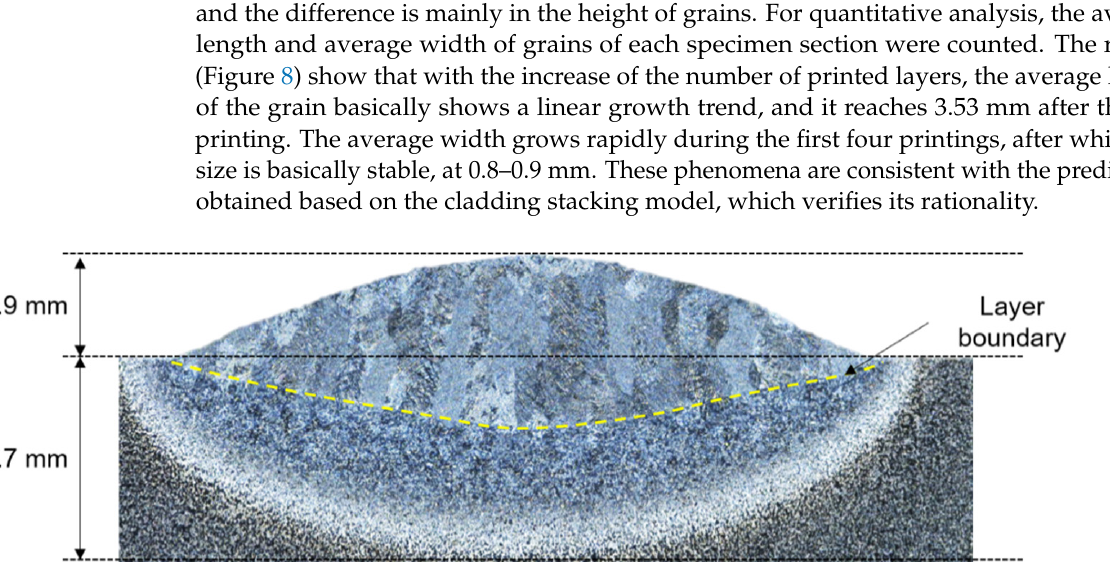
Figure 8. The average length and average width of grains. 3. A Process–structure–property Multi ‐ Scale Simulation Framework The cladding stacking model provides a basis for predicting the macro ‐ scale mechan ‐ ical properties of the final fabricated component by using meso ‐ scale scale numerical sim ‐ ulation results. For example, under the process parameters of the Section 2.2, the meso ‐ scale numerical simulation only needs to simulate the cladding processes of four layers. Then, the macroscopic mechanical properties of the final fabricated component can be ob ‐ tained by combining the microstructure simulation and the equivalent method of macro ‐ scopic properties. Based on this, according to the actual printing process of LMD, this study establishes a multi ‐ scale simulation framework that comprehensively considers the process–structure–property of additive manufacturing materials, as shown in Figure 9, by using the direct numerical simulation of meso ‐ scale process as a bridge to link the simu ‐ lation of the micro ‐ scale structure and the calculation of macro ‐ scale mechanical proper ‐ ties. In the module of the meso ‐ scale process simulation, HOTM is used to simulate the multi ‐ layer printing process. The fields of temperature, fluid flow and stress, pores, de ‐ formations, and other information can be obtained, and the dynamic process of powders melting and solidification can be explored.